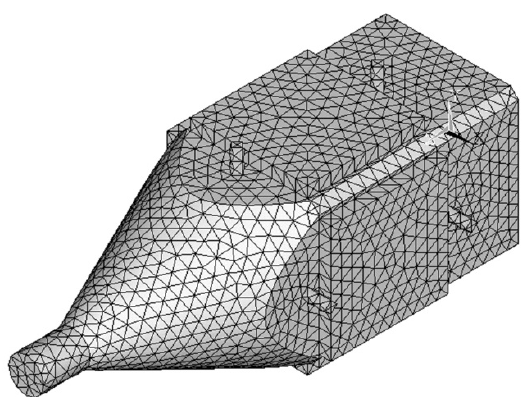
Figure 2. The FEM model of the proposed ultrasonic motor built in ANSYS. Table 1. The properties of the aluminum alloy and the PZT ceramics. PZT41 Aluminum